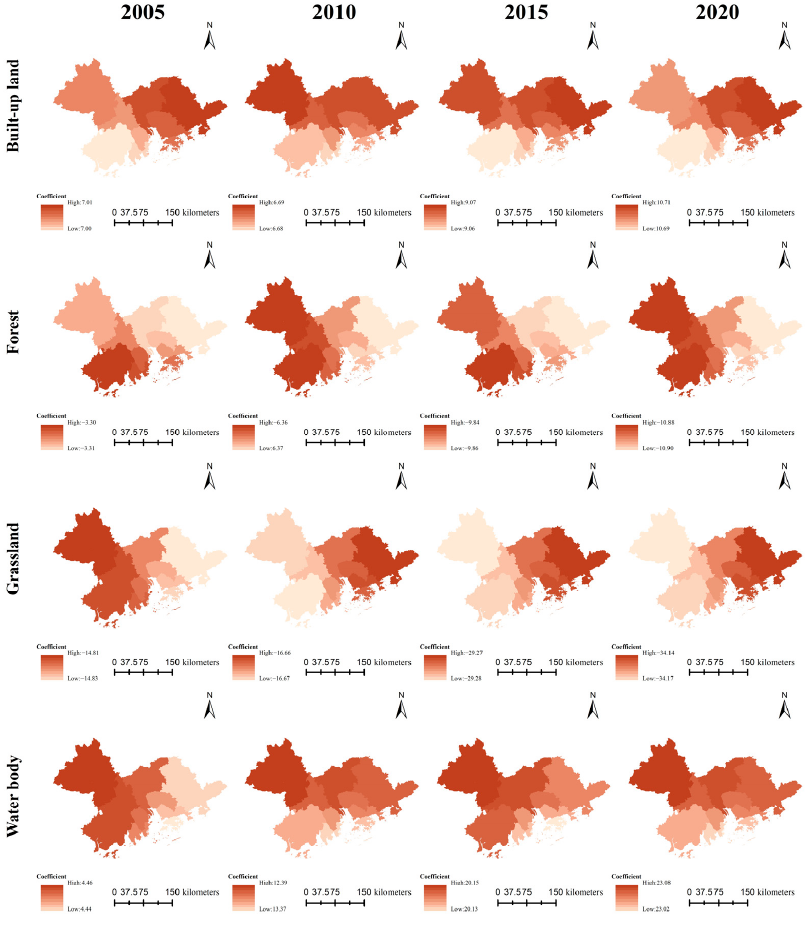
Figure 10. Coefficient of the GWR between UTCI and LUCC types in GBA.